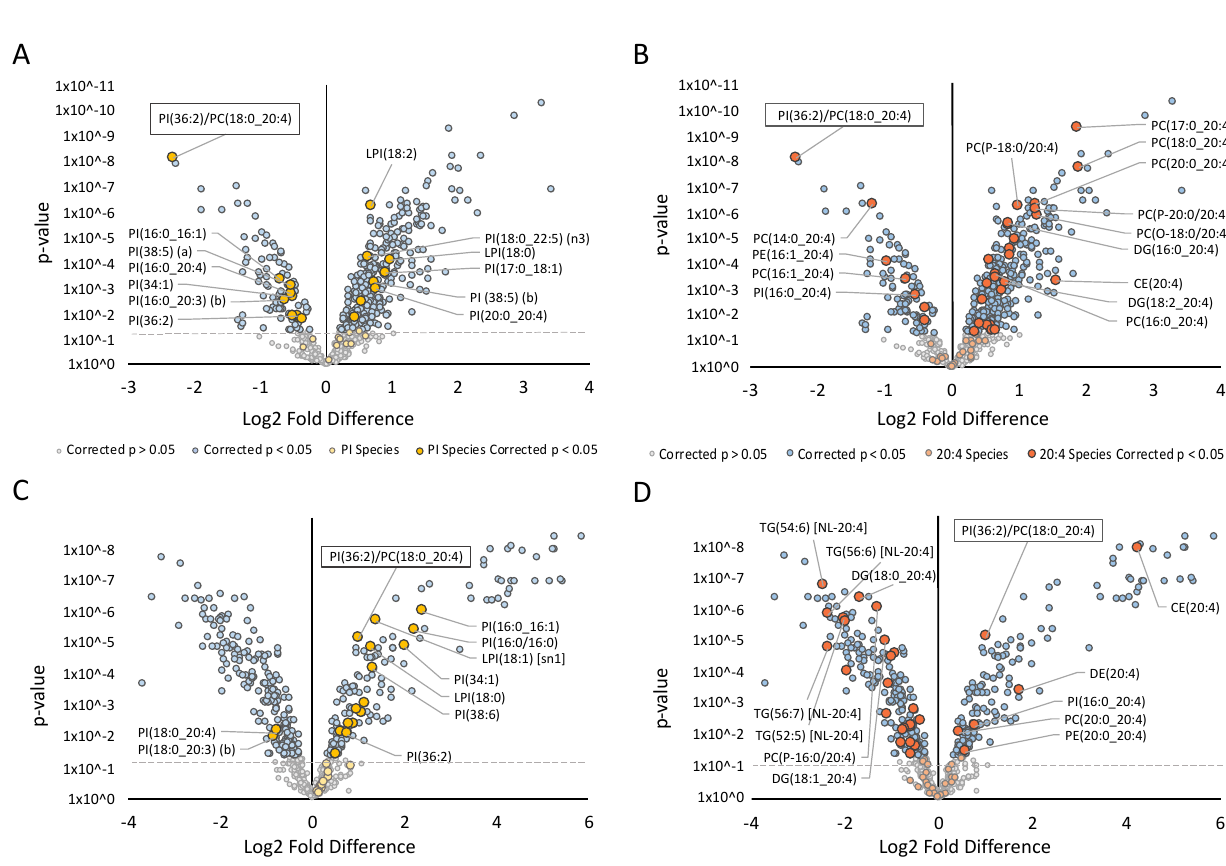
Figure 3. Effect of alternative cholesterol lowering treatments (cyclodextrin and cholesterol-loaded cyclodextrin) on the hepatic lipidome: Fold difference of 662 lipid species in Hep3B cells. Student’s t -tests were performed on 662 lipids follow- ing simvastatin treatment. Log2 fold difference denotes the change in ( A ) phosphatidylinositol species with 20 mg/mL cyclodextrin treatment; ( B ) arachidonic acid (20:4) containing species with 20 mg/mL cyclodextrin treatment; ( C ) phos- phatidylinositol species with 20 mg/mL COH-cyclodextrin treatment and ( D ) arachidonic acid (20:4) containing species with 20 mg/mL COH-cyclodextrin treatment.